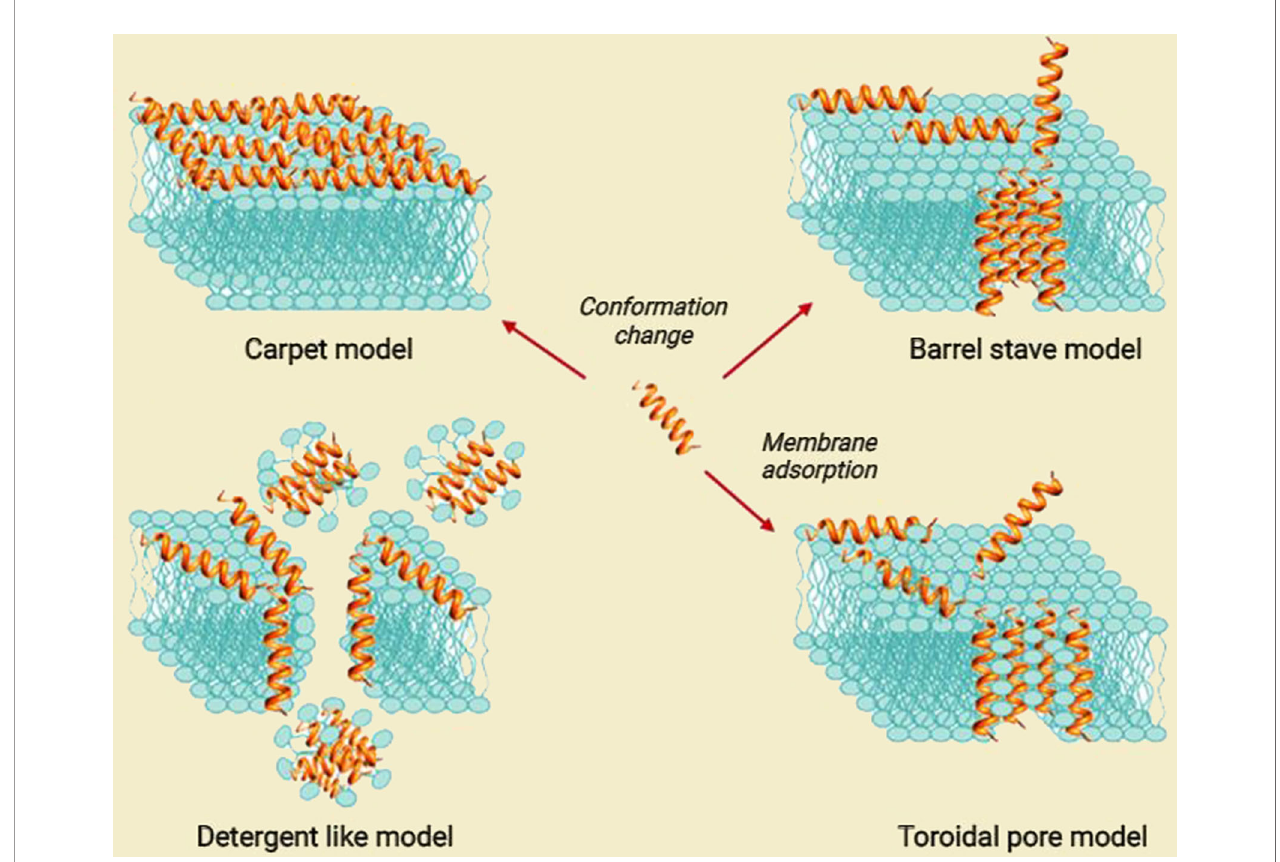
FIGURE 3 | Proposed models for the mode of action for extracellular AMP activity [modi fi ed from ref